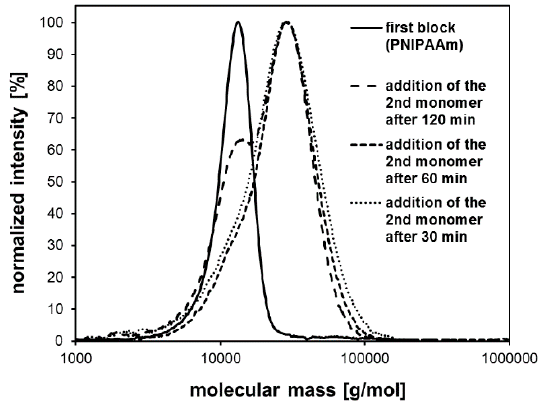
Figure 4. Molecular mass distribution of the PNIPAAm- b -PDMAAm copolymers obtained by sequential monomer addition as a result of SEC analysis.